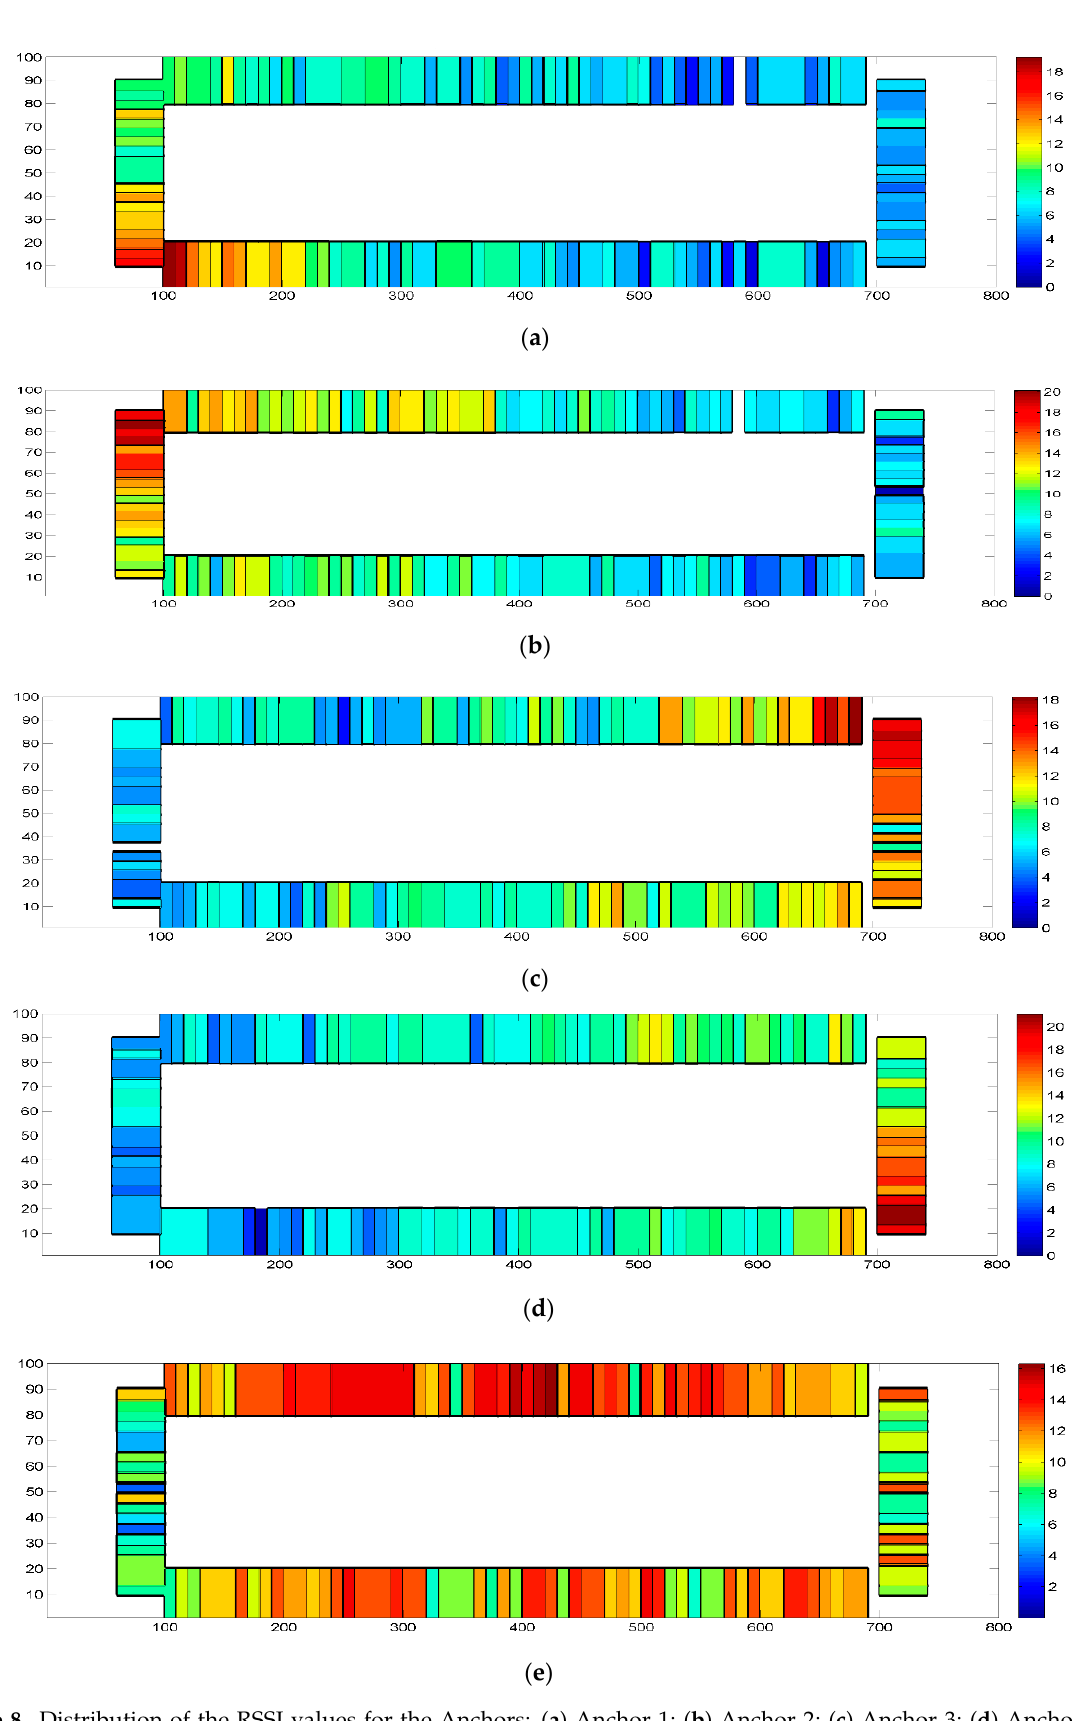
Figure 8. Distribution of the RSSI values for the Anchors: ( a ) Anchor 1; ( b ) Anchor 2; ( c ) Anchor 3; ( d ) Anchor 4; ( e ) Anchor 5.